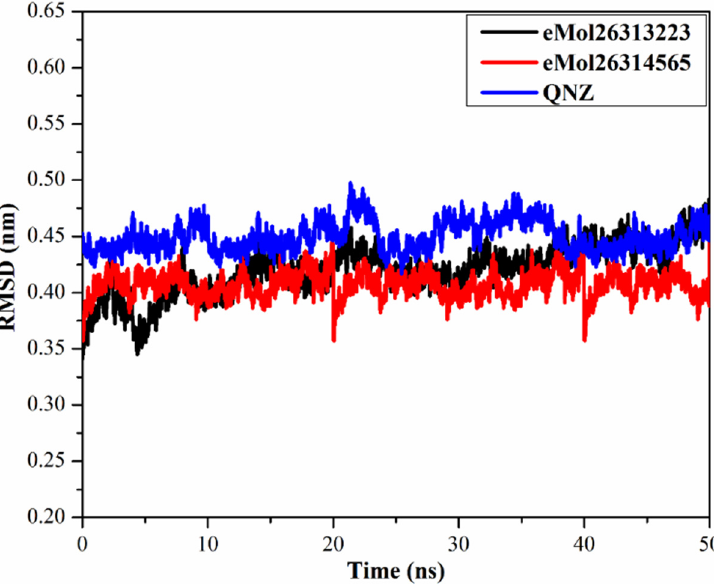
Figure 8. Root-mean-square deviation (RMSD) of the backbone atoms from the initial structure of eMol26313223 (in black), eMol26314565 (in red), and QNZ (in blue) towards mutated PBP2a allosteric site in acidic medium throughout the 50 ns MD simulation s .